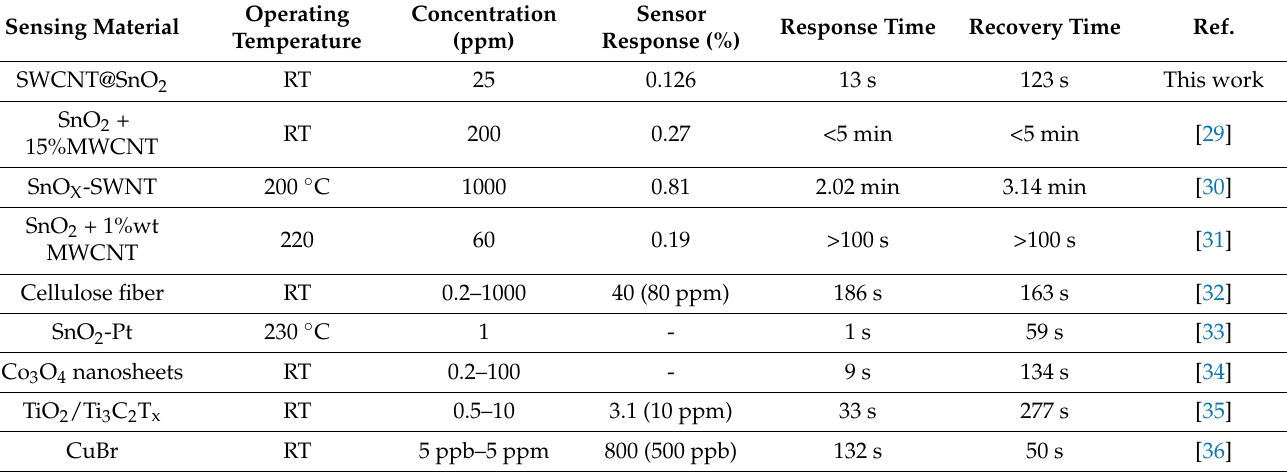
Table 1. Summarized sensor parameters for different works, as compared with the SWNT@SnO 2 sensors fabricated by LIFT. Sensing